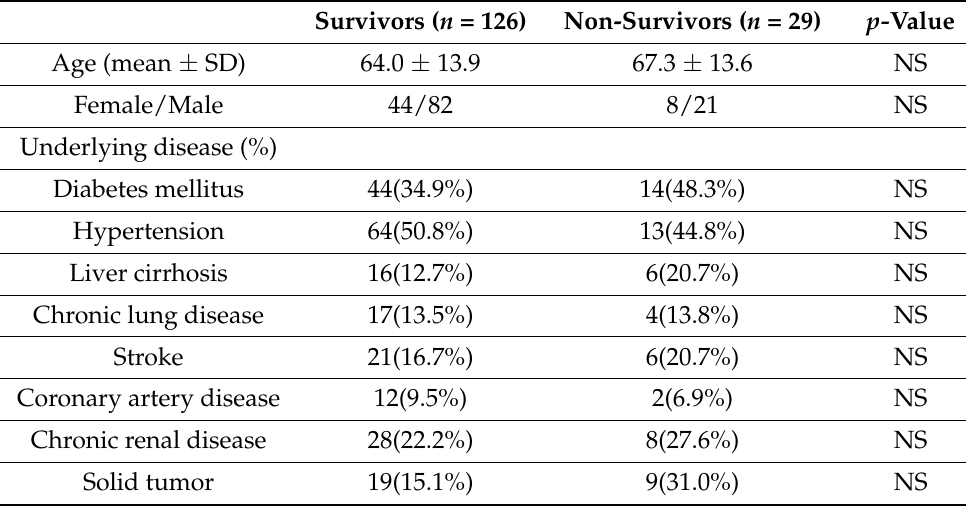
Figure 1. Scatterplot of serum sTREM-1 with other biomarkers and clinical sores. Table 3. Characteristics of survivors and non-survivors of septic